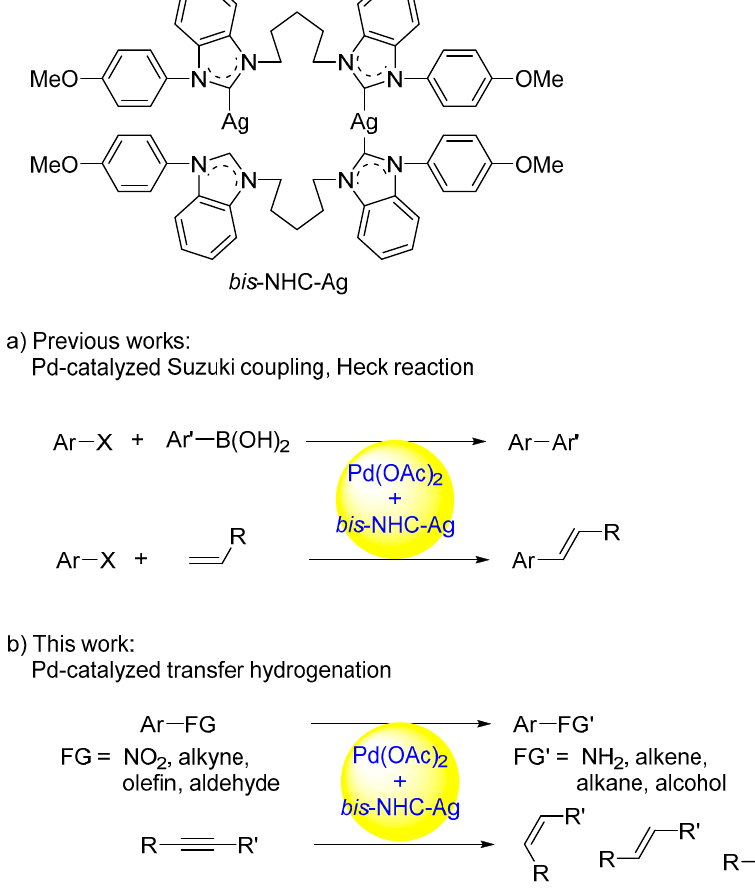
Figure 1. Reaction catalyzed by bis -NHC–Ag/Pd(OAc) 2 catalytic system.